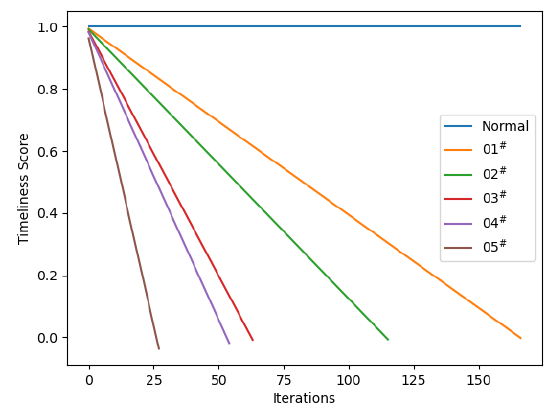
Figure 4. Convergence trend of the model when the data are updated later.